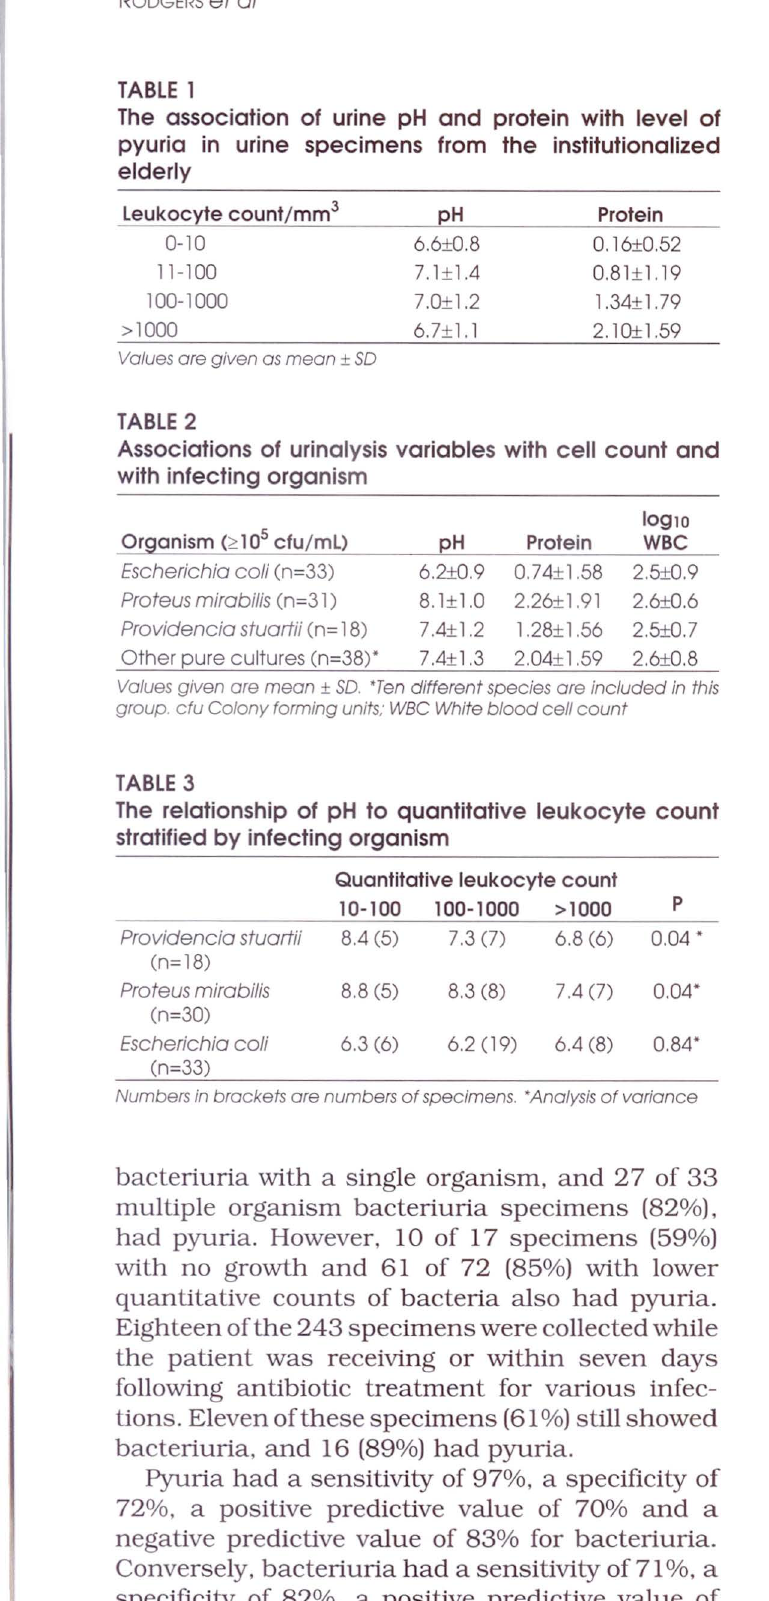
The association of urine pH and protein with level of pyuria in urine specimens from the institutionalized elderly